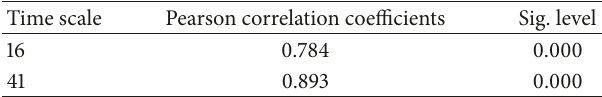
Table 1: Correlation coefficients of the WT real part coefficient series of 16- and 41-year scales between sunspot number and precipitation at Yan’an station from 1951 to